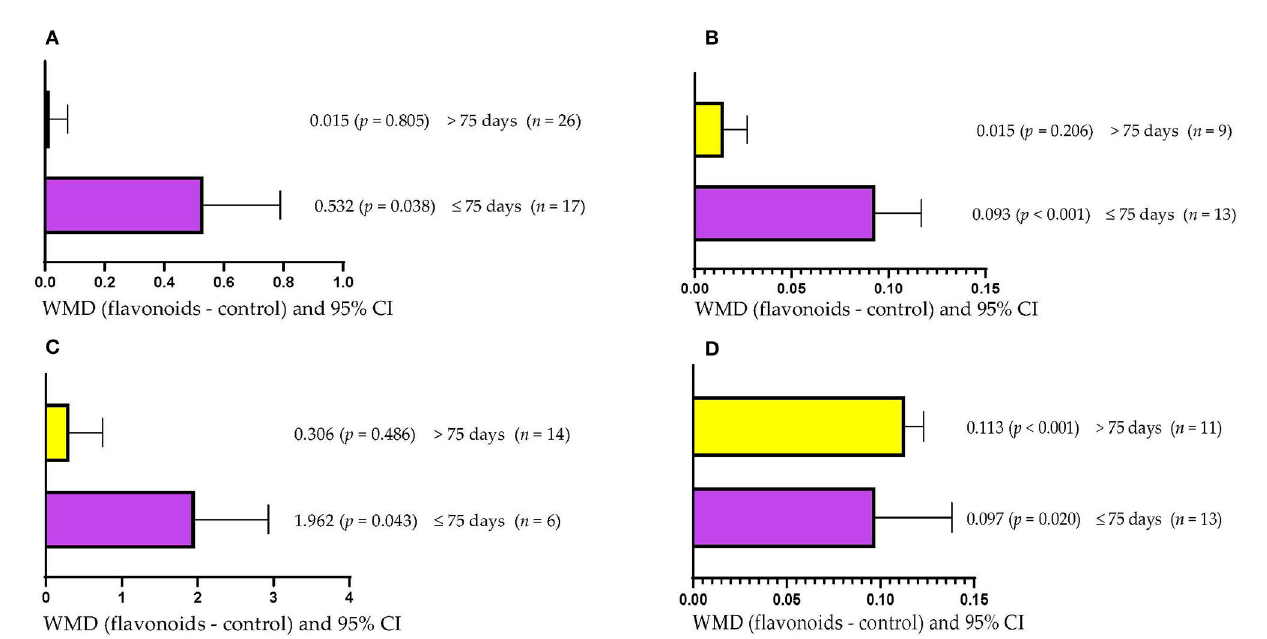
FIGURE2 Subgroup analysis [subgroup supplementation period (days)] of the effect of flavonoids on the diet of the cattle; WMDs, weighted mean differences = between flavonoid treatments and control. (A) Dry matter intake (DMI), kg/d. (B) Average daily gain (ADG), kg/d. (C) Propionate, mol/100mol. (D) Milk protein, g/100g.